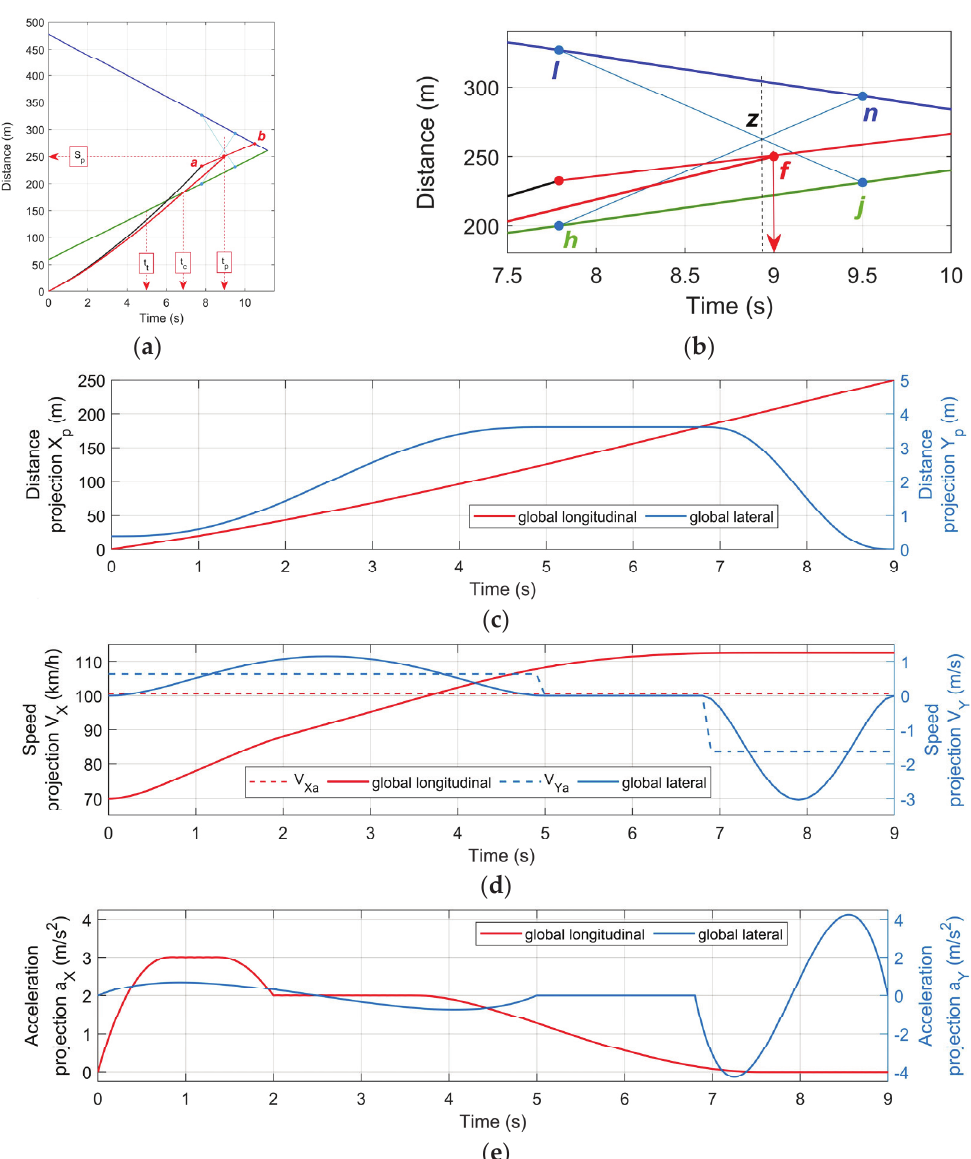
Figure 9. Planning reference tracks for state parameters: ( a ) Vehicle path's prognosis; ( b ) definition of point t p ; ( c ) predicted passing vehicle's global displacements; ( d ) plan of global velocities; ( e ) plan of global accelerations.